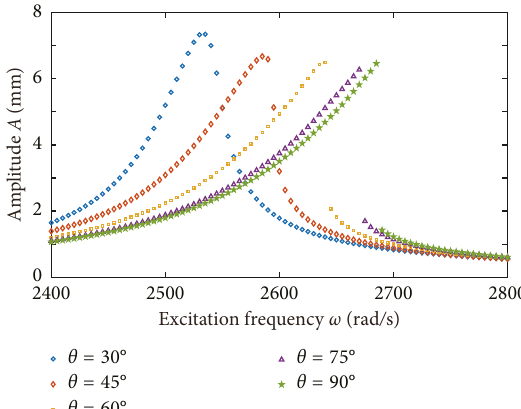
Figure 7: The amplitude-frequency curves at different contact